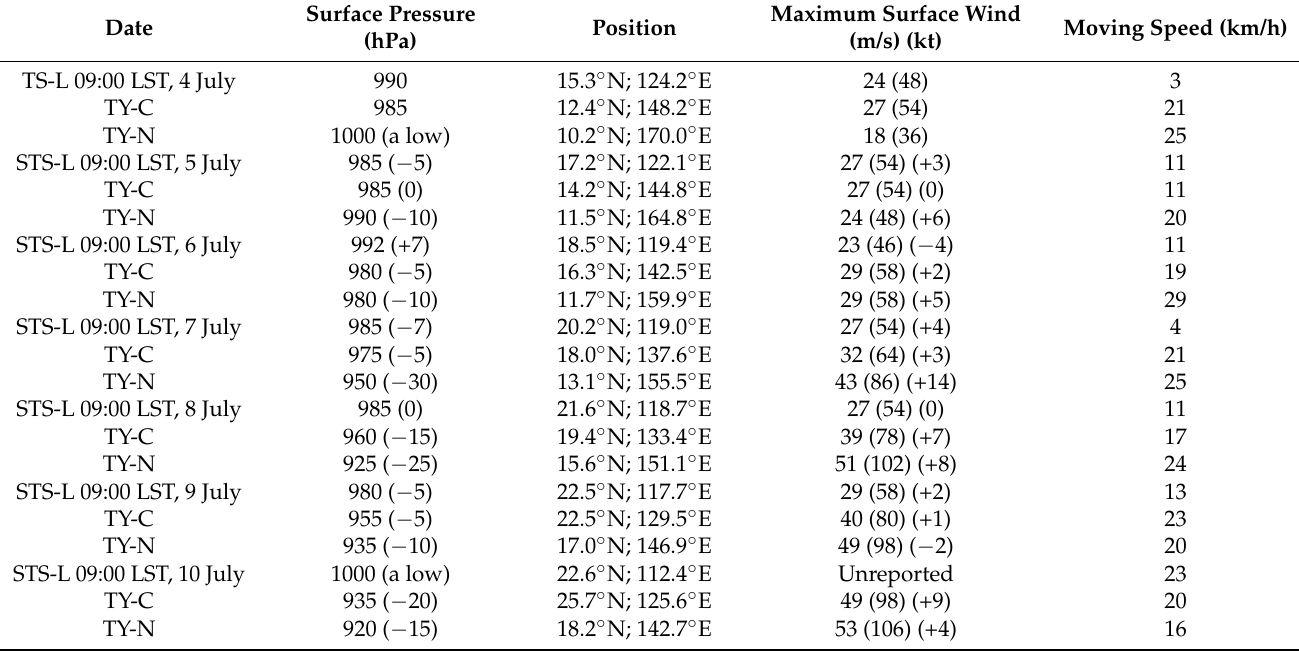
Table 1. Comparison of TY-1509 Chan-Hom (C), STS-1510 Linfa (L), and TY-1511 Nangka (N) from 4 to 10 July 2015. “(+)” and “( − )” indicate the increase and decrease in surface pressure, and maximum surface wind speed for 24 h, respectively (data were supplied by the KMA).